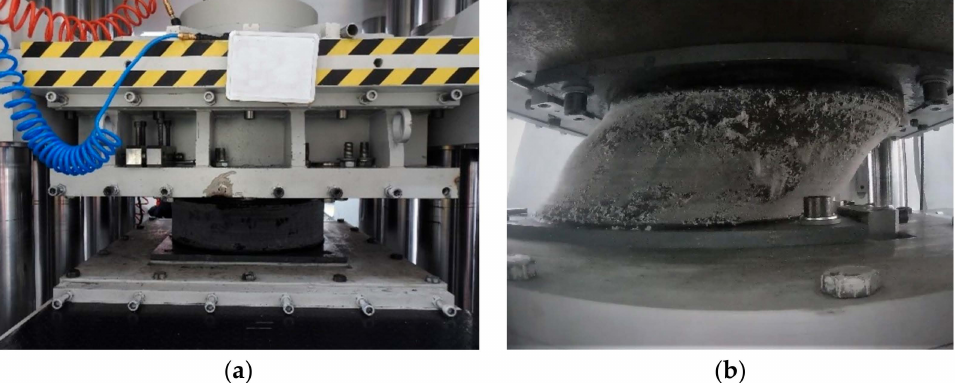
Figure 4. For − 20 ◦ C, 24 h exposure time loading combination ( a ) LRB placed in the seismic isolator test device ( b ) a view from cyclic motion.